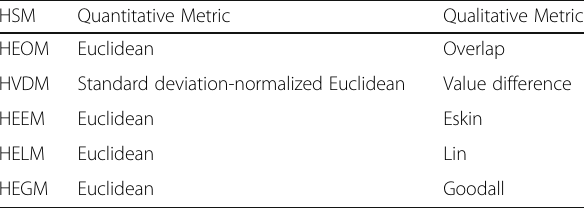
Table 1 Summary of Heterogeneous Similarity